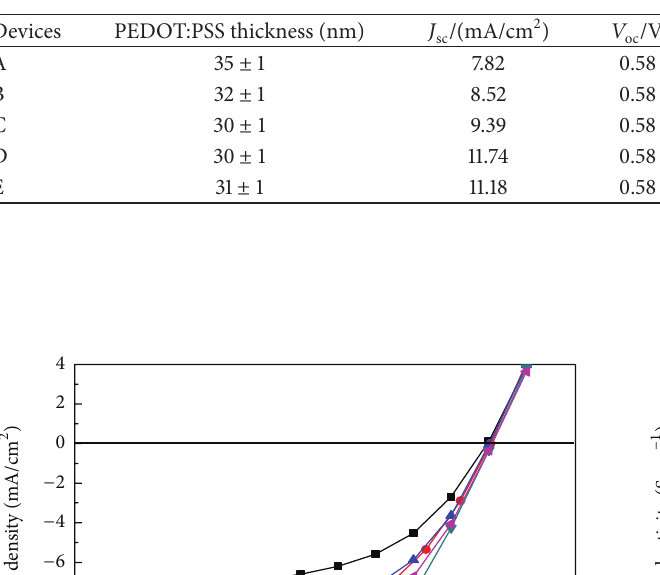
Table 1: The performance parameters of solar cell based on P3HT:PCBM with different volume ratios of nitrobenzene added in blend solutions.